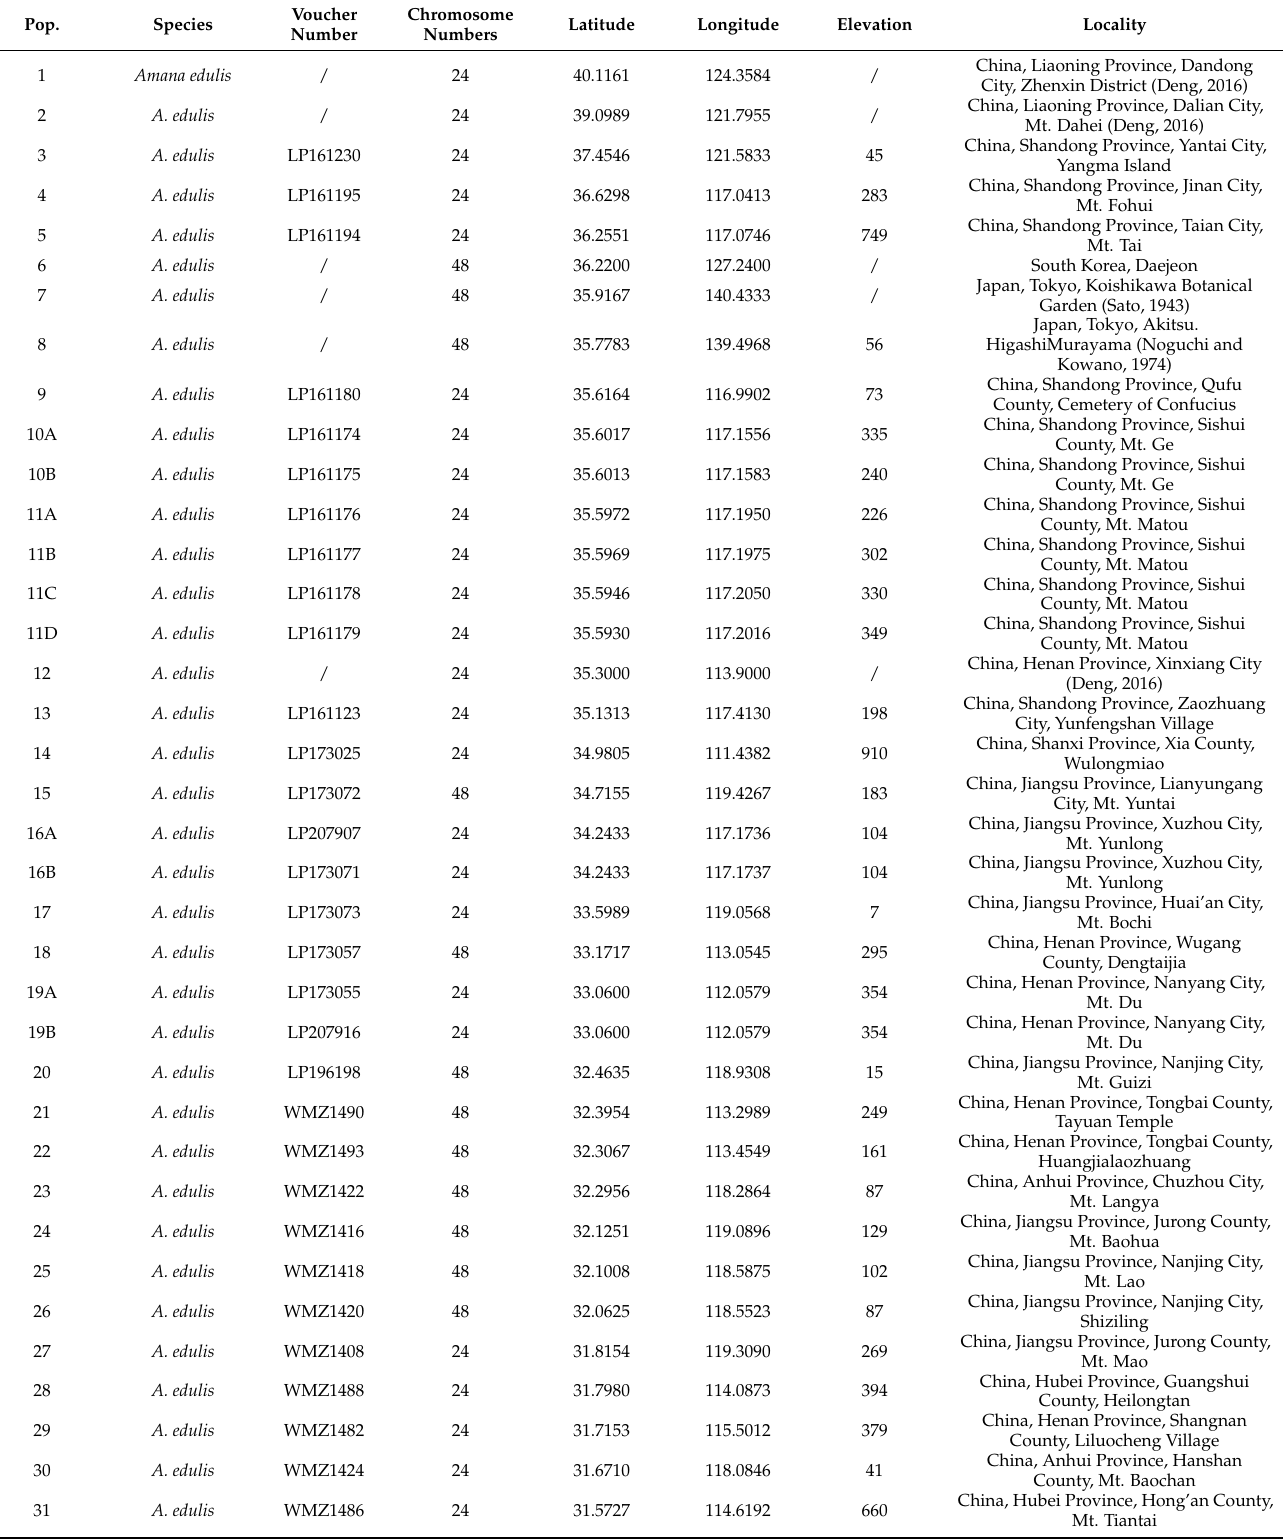
Table 1. The populations information and ploidy levels found in Amana . A, B, C refer to different collections from the same